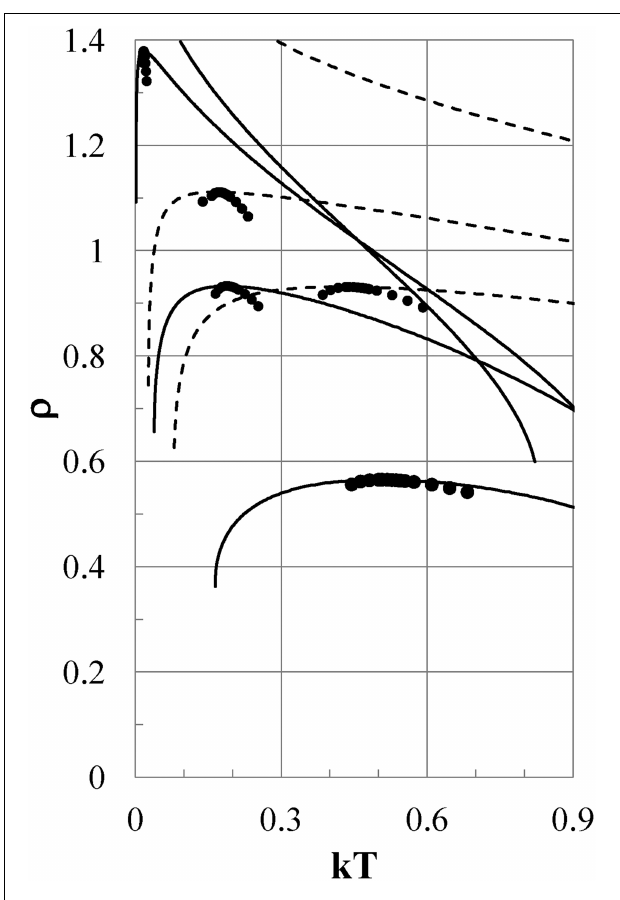
FIGURE 5 | Density-temperature curves at P c . Full lines are for Models φ i ( i = 2–5), and dashed lines are for φ i ( i = 9-7) from the bottom to the top of the figure, respectively. P c = 0.0974, 0.1216, 0.1173, 0.1025 for Models φ i ( i = 2–5), and P c = 0.384, 0.441, 0.571 for φ i ( i = 9–7), respectively. Full circles show experimental densities of liquid water at P = 1 bar.